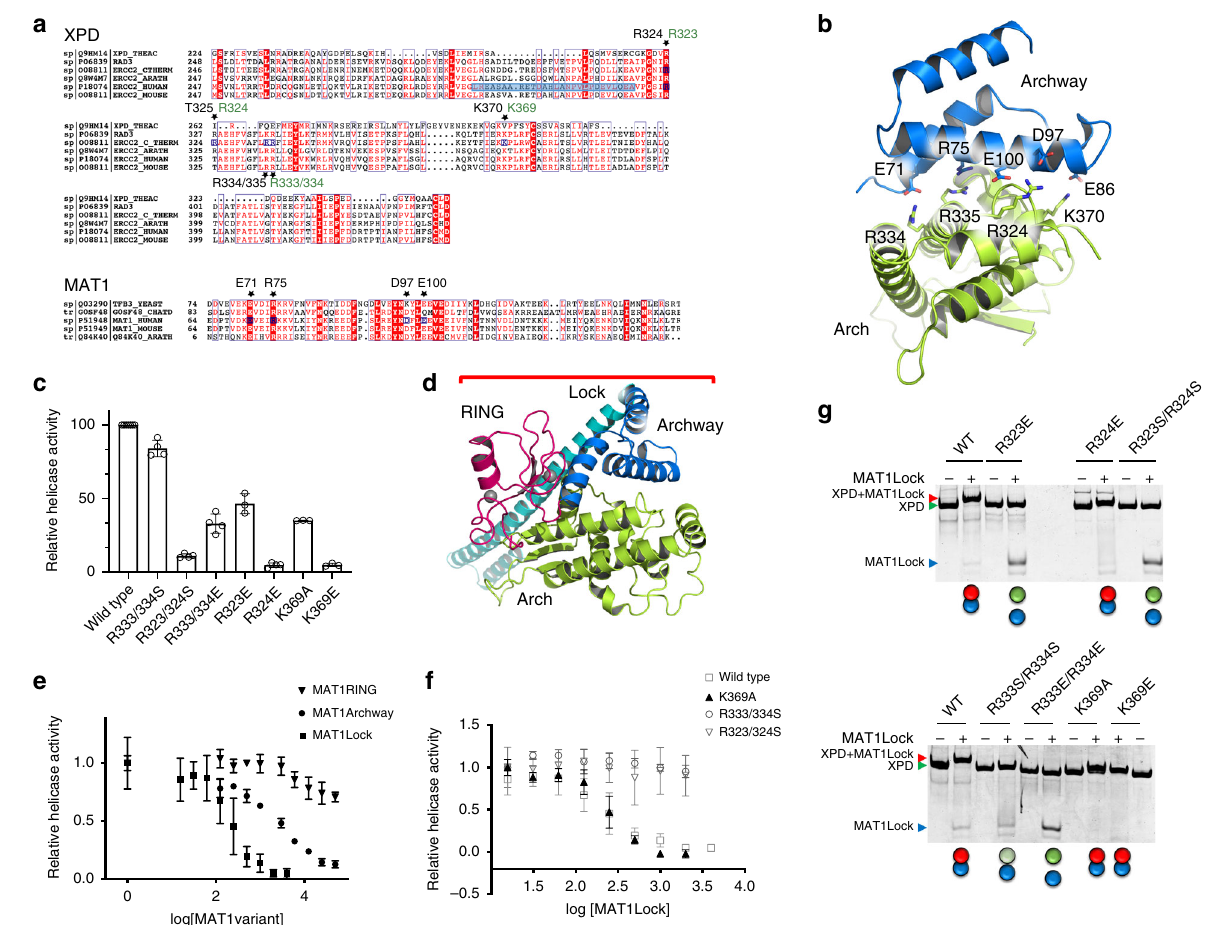
Fig. 3 Functional mutagenesis studies on ctXPD and ctMAT1Lock. a Sequence alignment of the Arch domain of XPD and the coiled coil region of MAT1 from different organisms (order of appearance: T. acidophilum , S. cerervisiae , C. thermophilus , A. thaliana , H. sapiens , and M. musculus ; uniprot code indicated). Targeted residues are marked with a star and are labeled in black for the human and in green for the C. thermophilum proteins. The plug region in human XPD is marked in blue. b Cartoon representation of the human Arch domain MAT1 complex with the residues chosen for functional mutagenesis studies highlighted in stick representation; color coding is the same as in Fig. 2a. c Helicase activity of 250nM wild-type ctXPD or its variants in the presence of 250 nM ctp44 measured using a 5 ′ OH substrate. The helicase activity of the wild-type complex was set to 100%. Average values and SD are shown and were derived from two biological replicates combined in at least three technical replicates. d Model of MAT1 engaged with the Arch domain of XPD based on pdb code 6nmi. The MAT1RING is shown in magenta, MAT1Archway in blue, Arch in green, and in cyan we have labeled the extension of MAT1 visible in the 6nmi structure. e ctXPD helicase inhibition in the presence of the ctMAT1 constructs ctMAT1RING, ctMAT1Archway and ctMAT1Lock. Average values and SD are shown and were derived from at least three technical replicates. f Helicase activity of wild-type ctXPD and ctXPD variants in the presence of increasing concentrations of MAT1Lock. Average values and SD are shown and were derived from at least three technical replicates. g Native PAGE analysis of the ctXPD ctMAT1Lock interaction. The green and red circles below the gels indicate whether complex formation was observed. Green represents free ctXPD and blue free MAT1Lock (lightgreen indicates partial complex formation), whereas red is used for ctXPD when ctXPD and ctMAT1Lock form a complex (also indicated by the contacting circles). Source data are provided as a Source Data fi le.